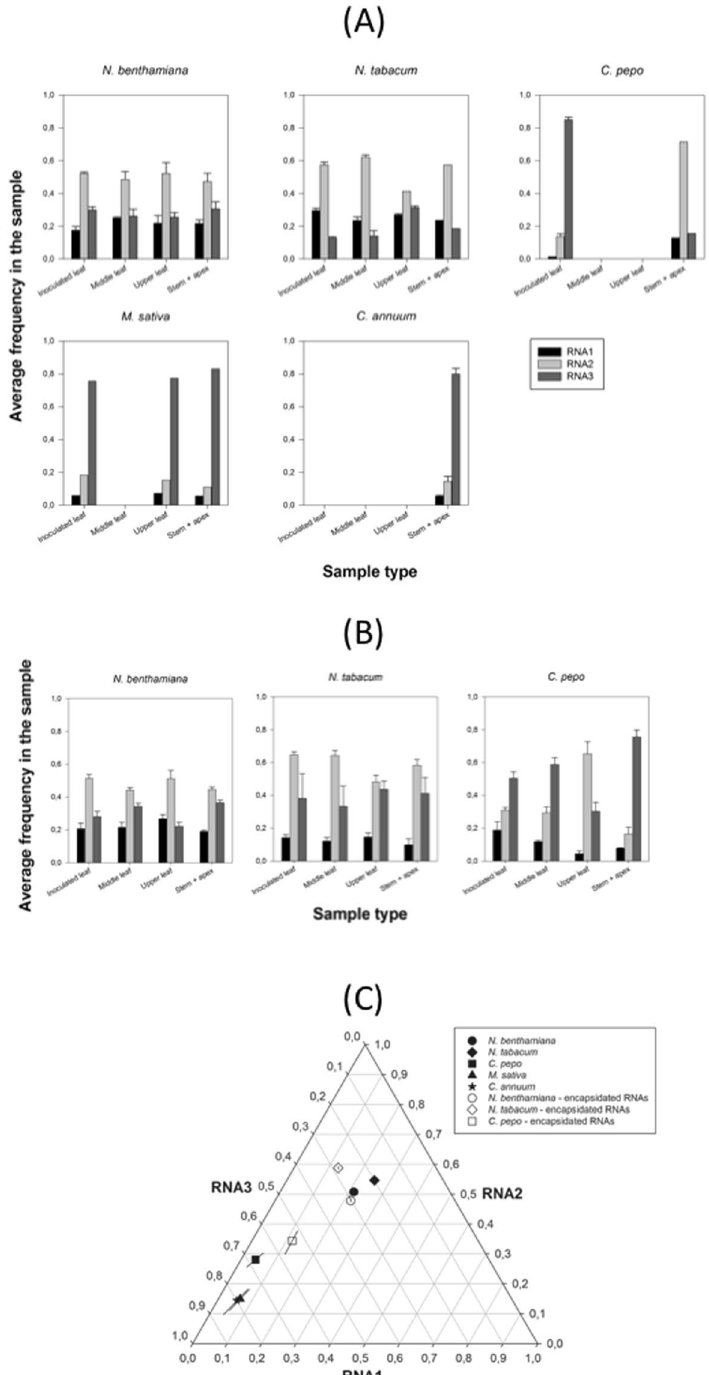
Figure 3. Effect of host species in the accumulation of each genomic segment of AMV. ( A ) Experimental determinations (by RT-qPCR) of the frequency of each AMV genomic in total RNA extractions from five different host species. Bars represent the mean of n = 3 plants per hsot species; error bars represent ± 1 SEM. ( B ) As in ( A ) but determined for encapsidated RNAs. No data are available for C. annuum and M. sativa . ( C ) Normalized frequency ternary plot showing the effect of host species in the estimated SGF . Solid symbols represent the marginal mean frequencies estimated from total RNA samples. Open symbols represent the marginal mean frequencies estimated from virion RNA samples. Lines crossing symbols represent 95%